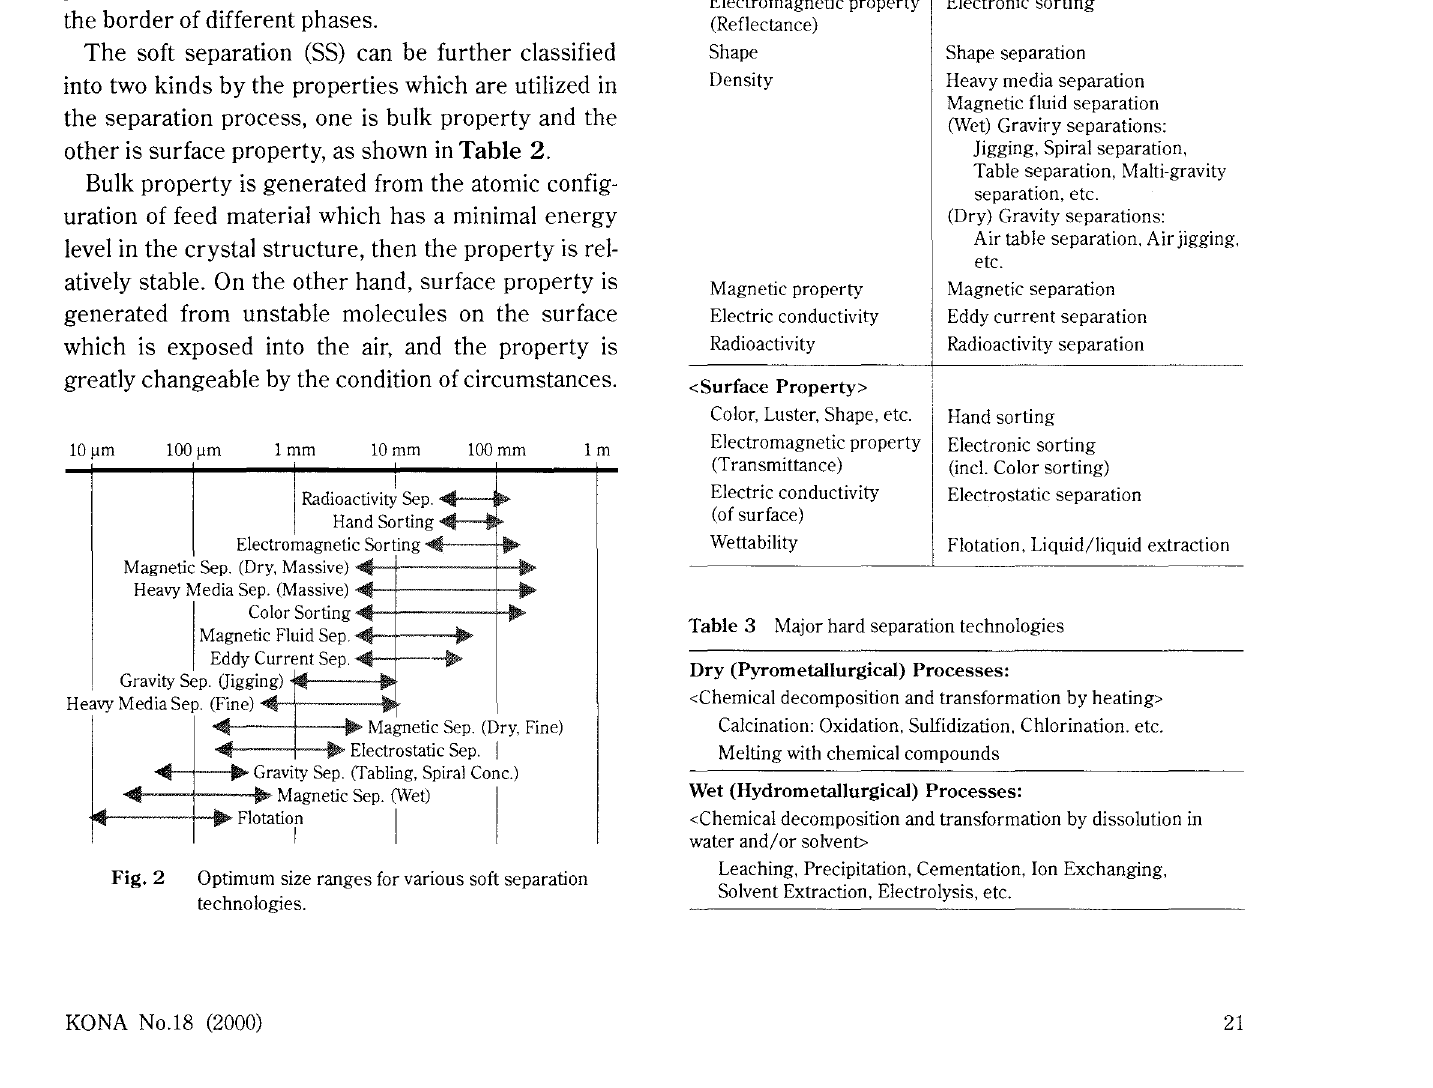
Table 3 Major hard separation technologies Dry (Pyrometallurgical) Processes: <Chemical decomposition and transformation by heating> Calcination: Oxidation, Sulfidization, Chlorination.